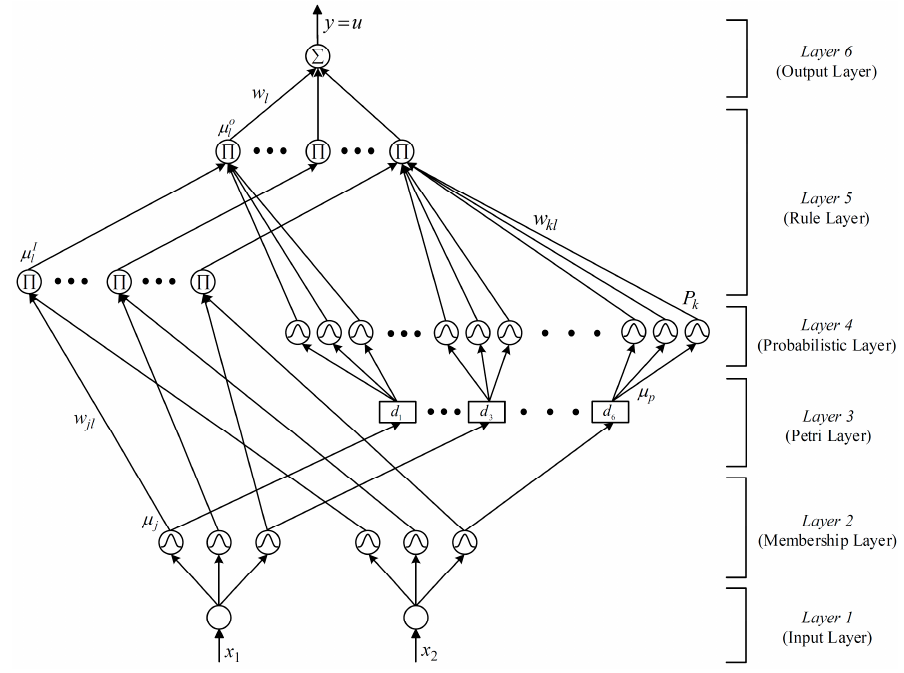
Figure 3. Network structure of PPFNN.